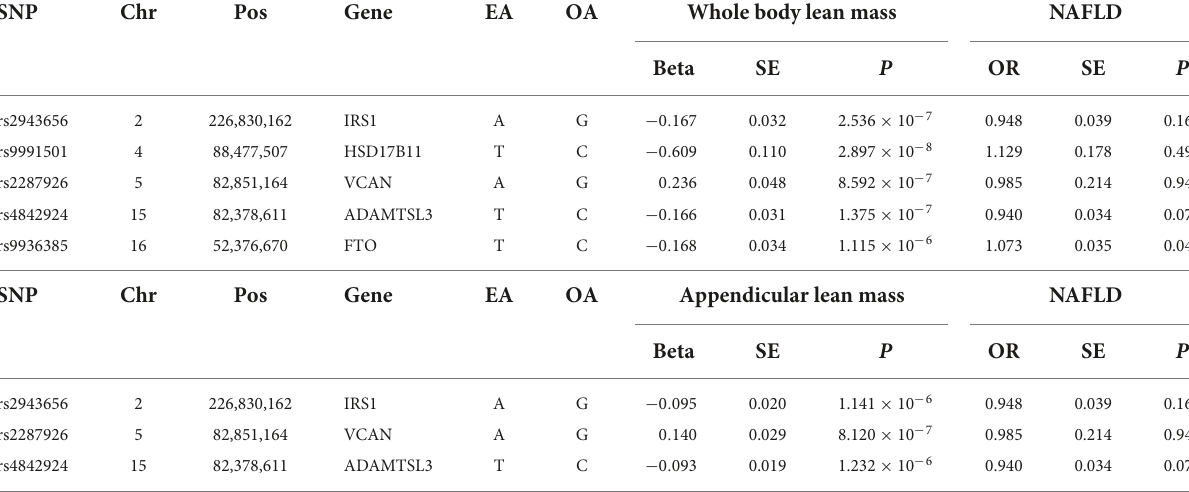
TABLE 1 Genetic instruments for lean body mass and their associations with NAFLD.